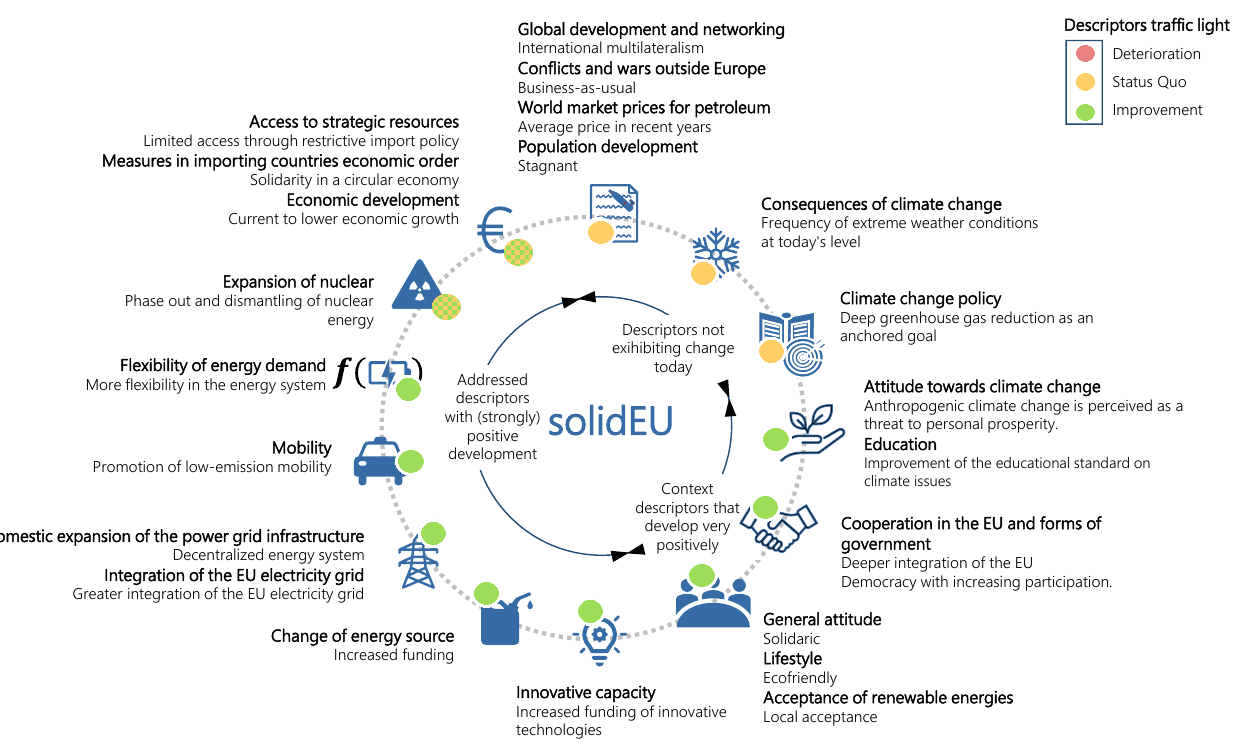
Figure 3. SolidEU scenario descriptors and trends [30].